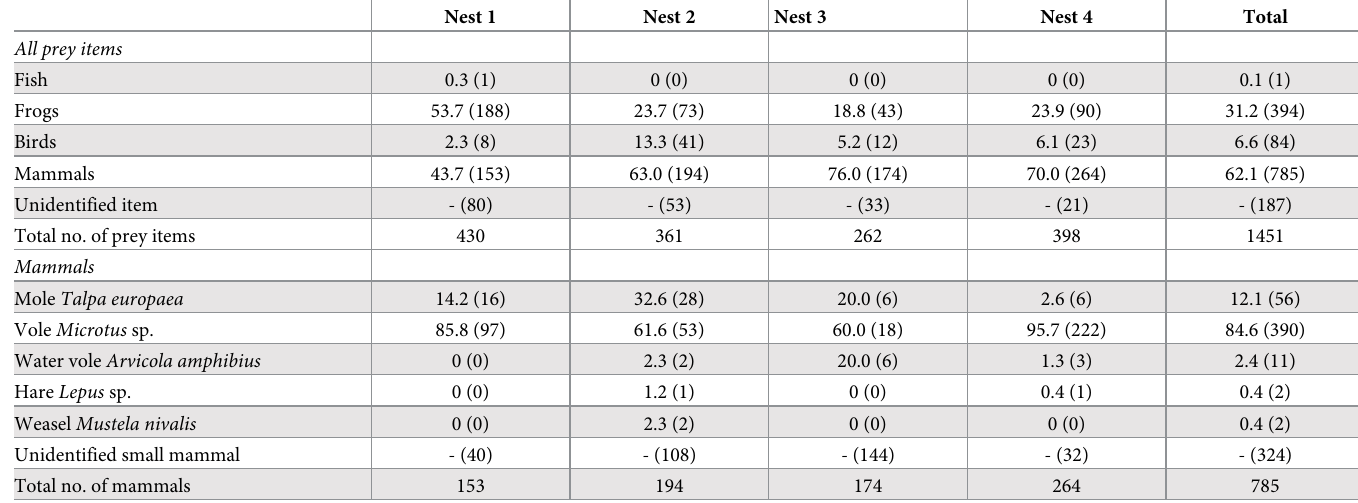
Table 2. Proportions (%, sample size in brackets) of the main prey groups (upper half) and mammal species (lower half) in the four studied nests of the Lesser Spot- ted Eagle. Unidentified prey items were excluded from calculations of